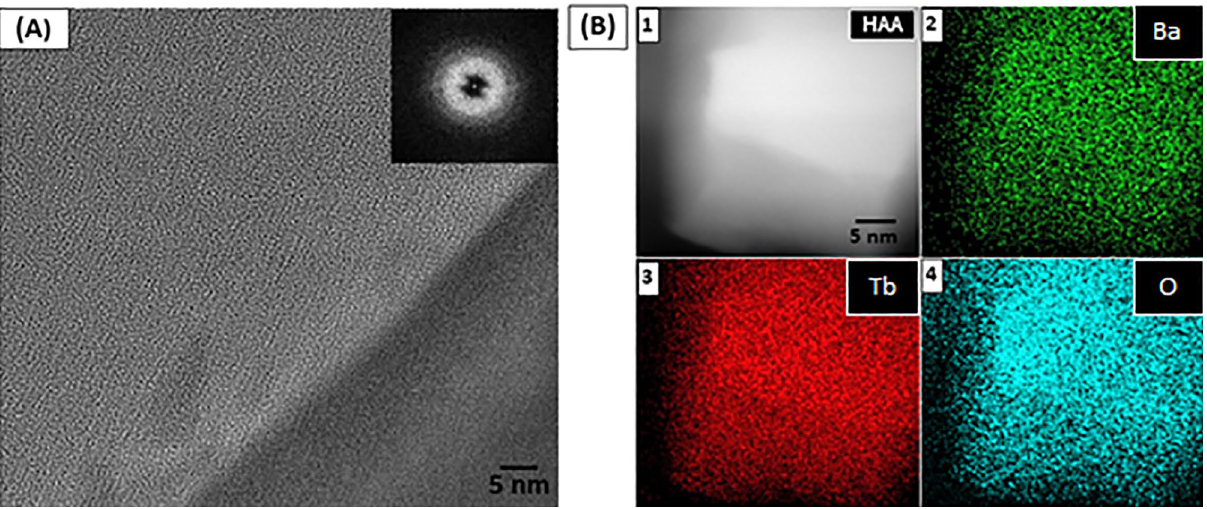
Figure 4. ( A ) HRTEM micrograph of BGB-18Tb [the inset shows the fast Fourier transform (FFT)]. ( B ) HAADF mode (Z-contrast) image of the analyzed area (1) and elemental EDS mapping for Ba-K (2), Tb-L (3), and O-K